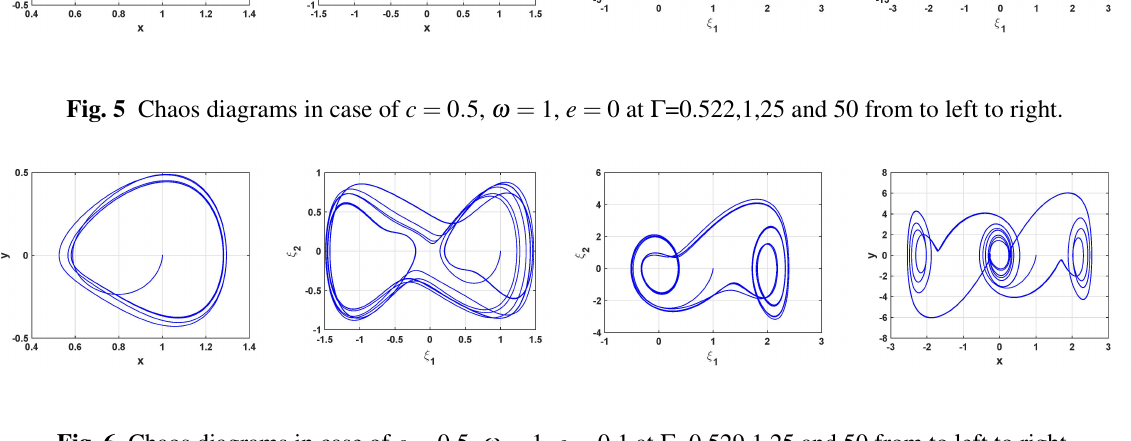
Fig. 6 Chaos diagrams in case of c = 0 . 5, ω = 1, e = 0 . 1 at Γ =0.529,1,25 and 50 from to left to